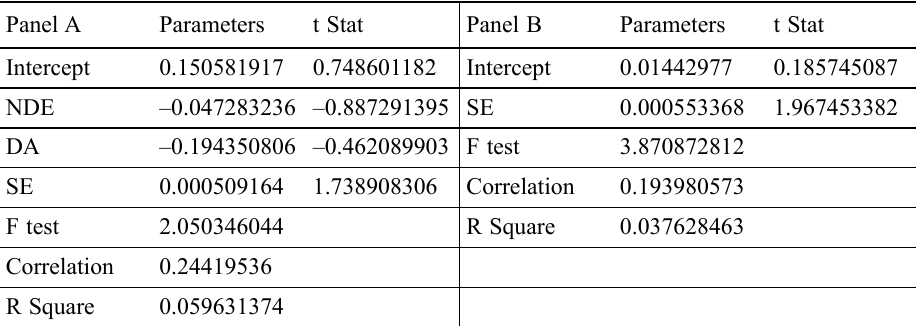
Table 4. Statistical Description of Stock Return